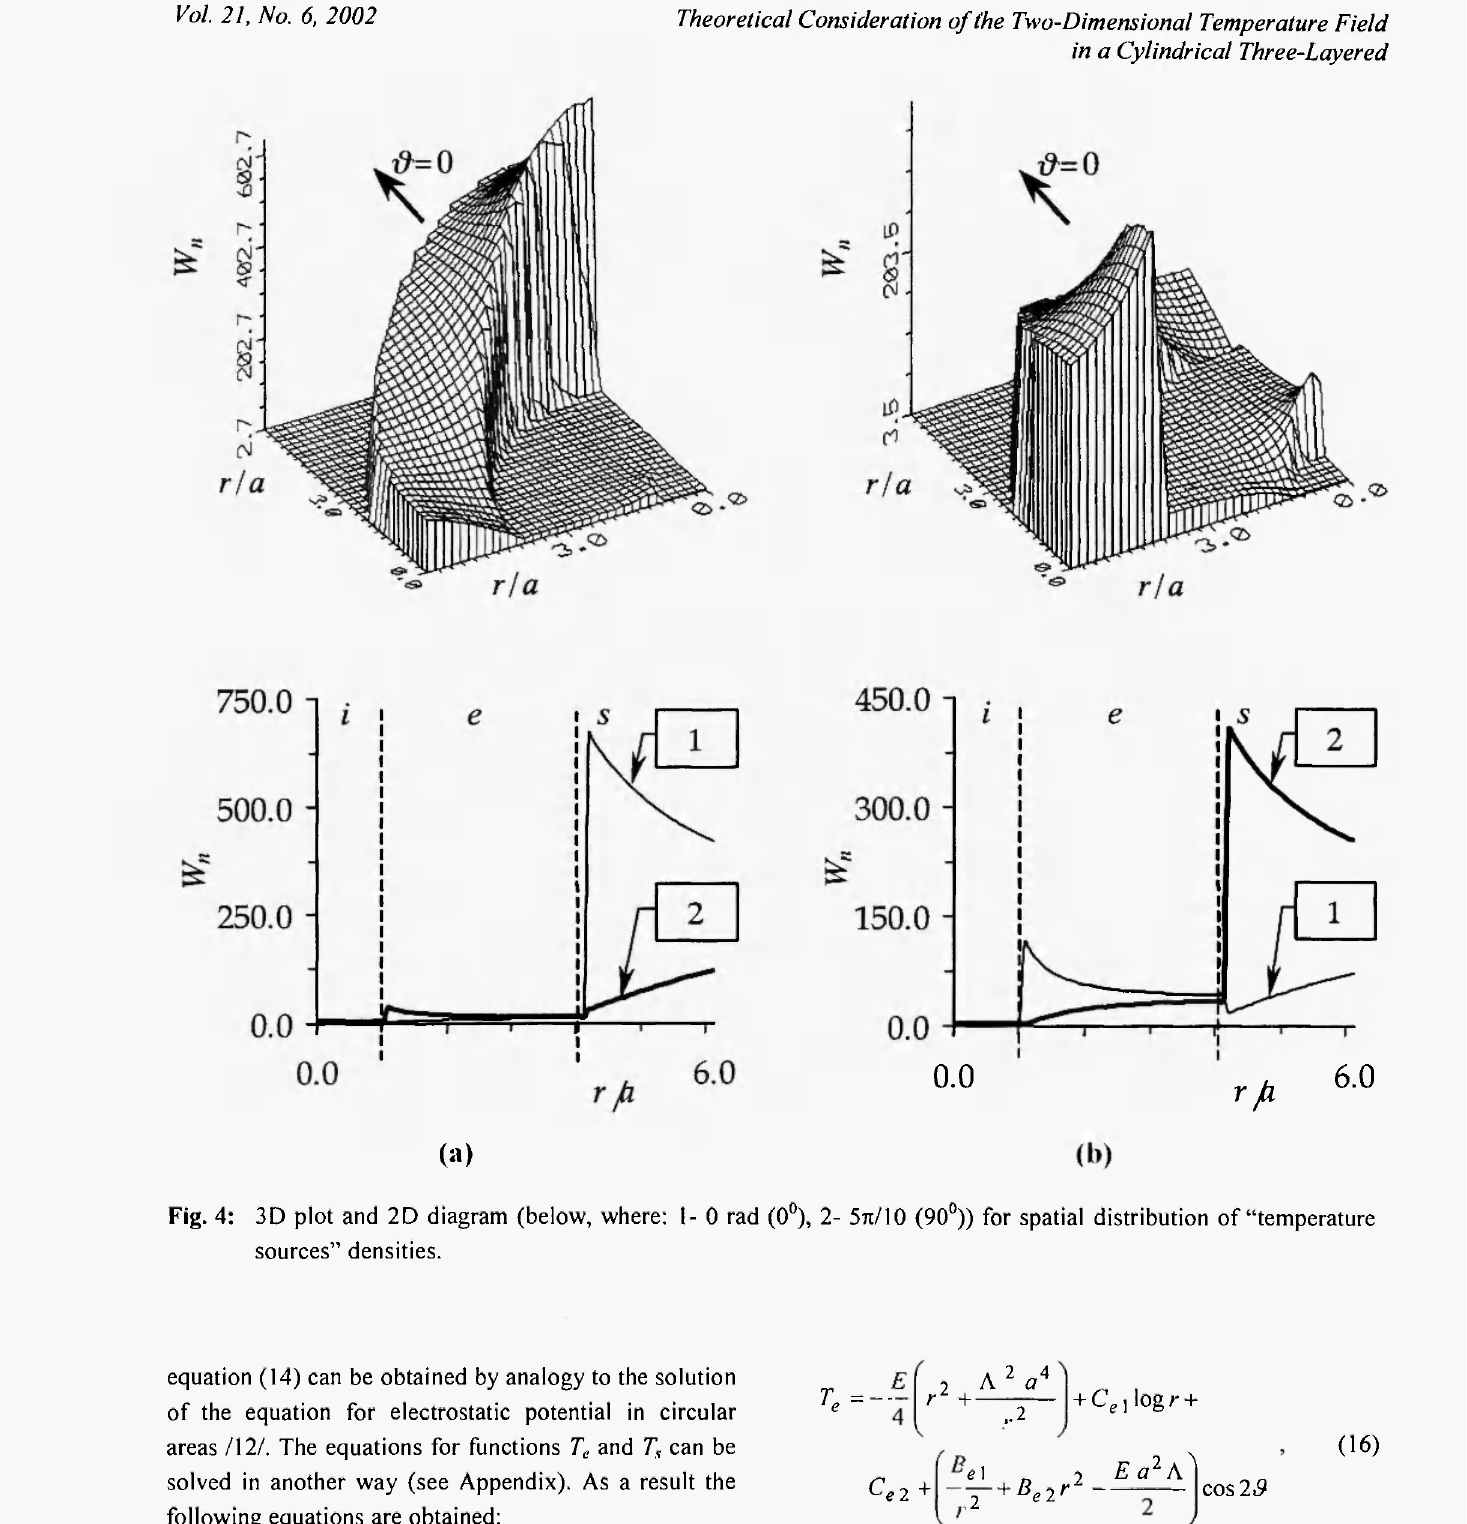
Fig. 4: 3D plot and 2D diagram (below, where: 1- 0 rad (0°), 2- 5π/10 (90°)) for spatial distribution of "temperature sources"